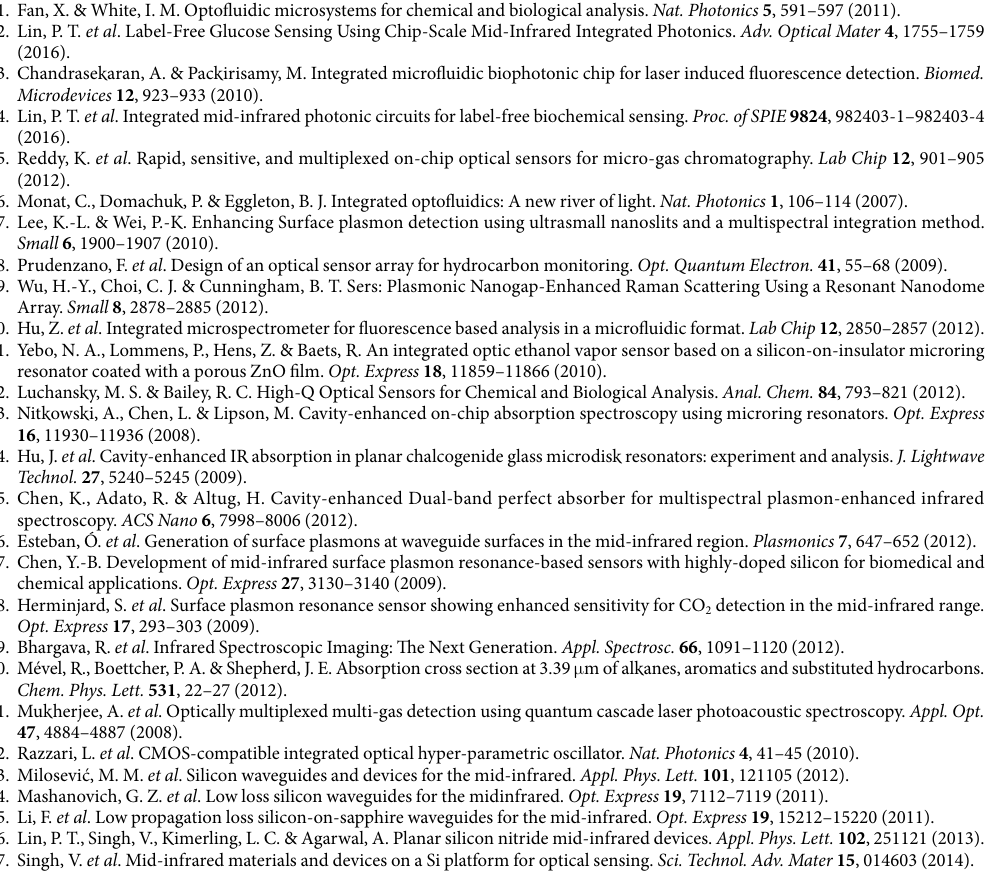
7 Scientific RepoRts | 7: 5836 | DOI:10.1038/s41598-017-05711-4